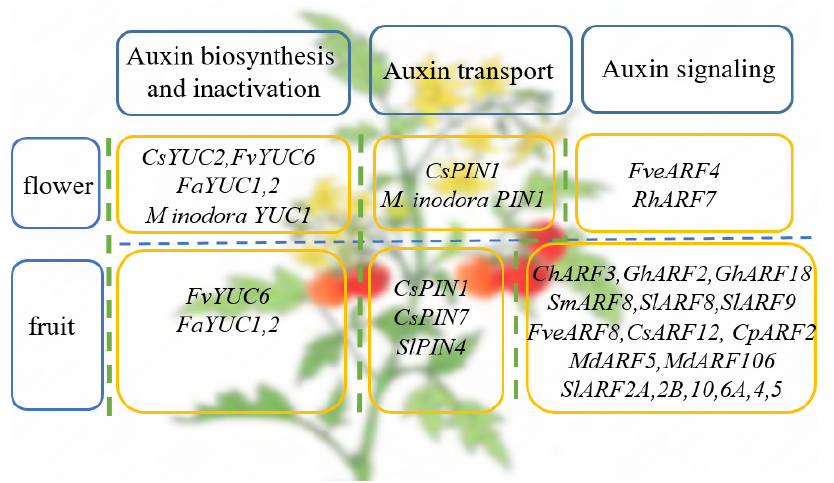
Figure 3. Auxin-related genes that play a role in the reproductive growth of horticultural plants.